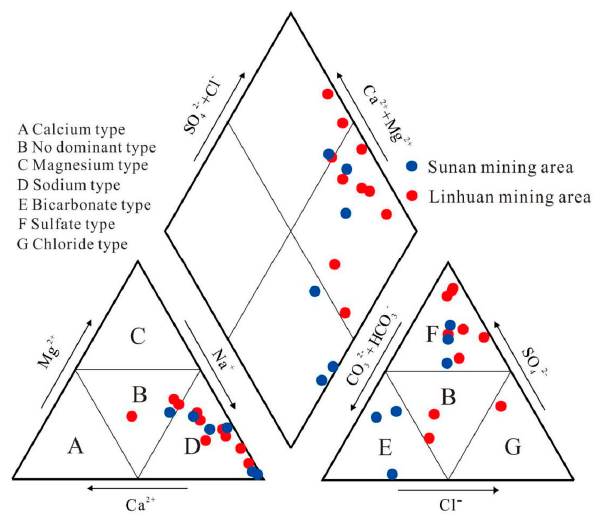
Figure 5. Piper trigram of the Taiyuan formation limestone water constant components in the study area.